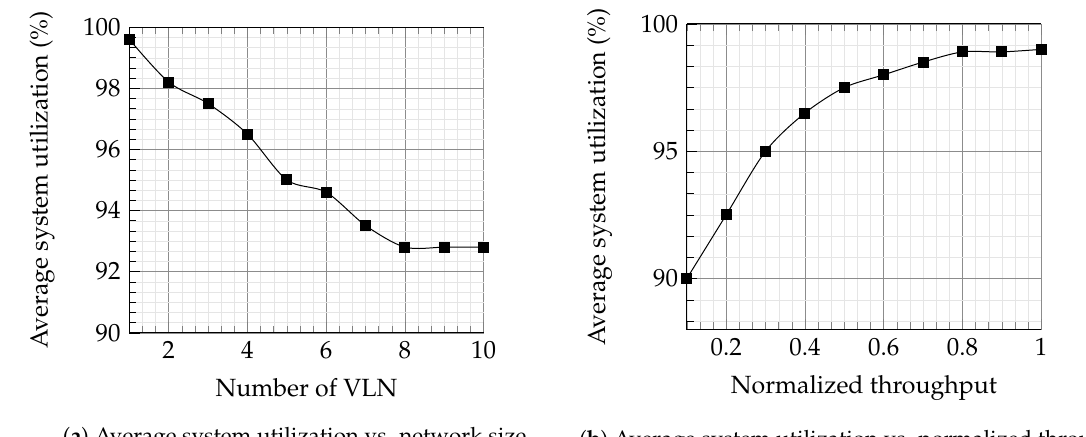
Figure 7. Average system utilization vs. network size and network